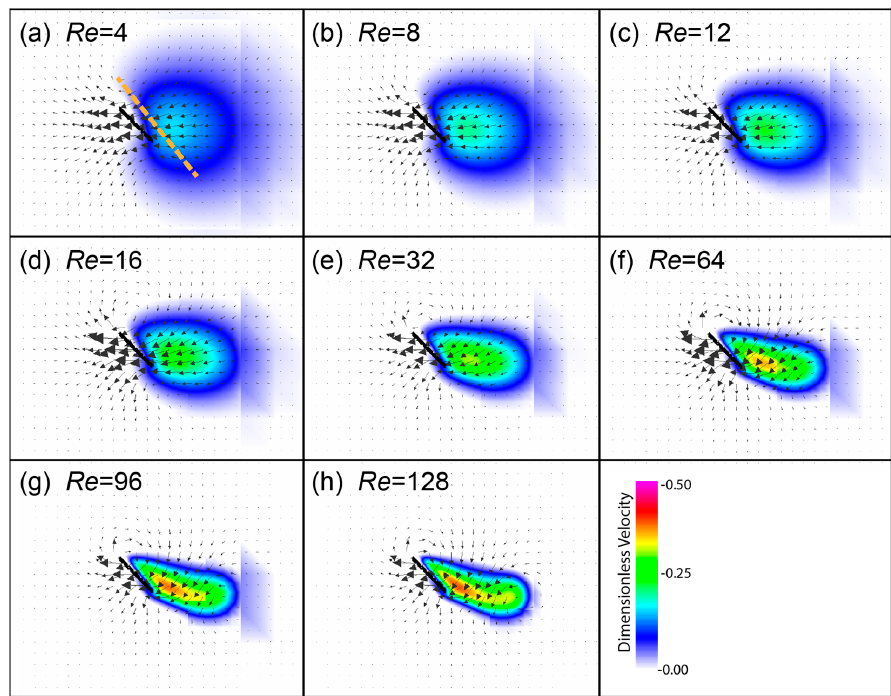
Figure 9. The vector fields and spanwise flow at mid-stroke obtained from three-dimensional computational simulations (angle of attack = 45°, Re range from 4 to 128). The cross-section shown is through the chord at the midpoint of the span. The vectors show the direction of flow and are scaled to the magnitude of the flow velocity. The color map shows the spanwise flow (min = 0 and max = 0.5) normal to the plane. Note that the wing is traveling to the left. The average spanwise flow was calculated along the dashed transect in ( a ) and is shown in Figure 10.